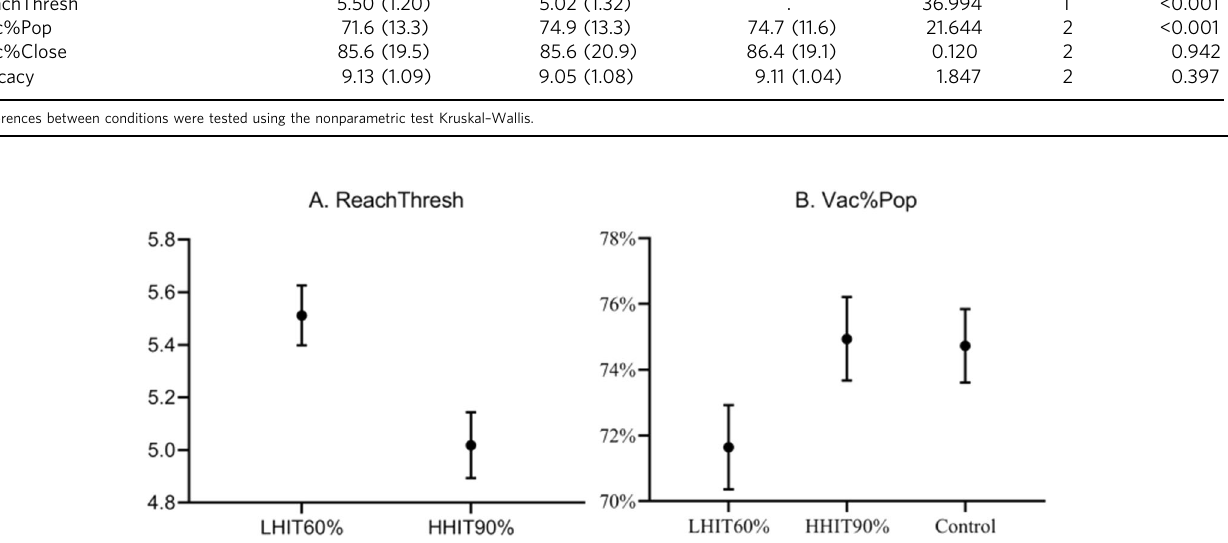
Fig. 1 Differences in means between high and low herd immunity thresholds, showing 95% con fi dence intervals. Note: For A , the Y -axis is the belief about reaching the threshold (1 = completely unlikely, 4 = either or, 7 = completely likely). For B , the Y -axis is the percentage one believes will get vaccinated in the total